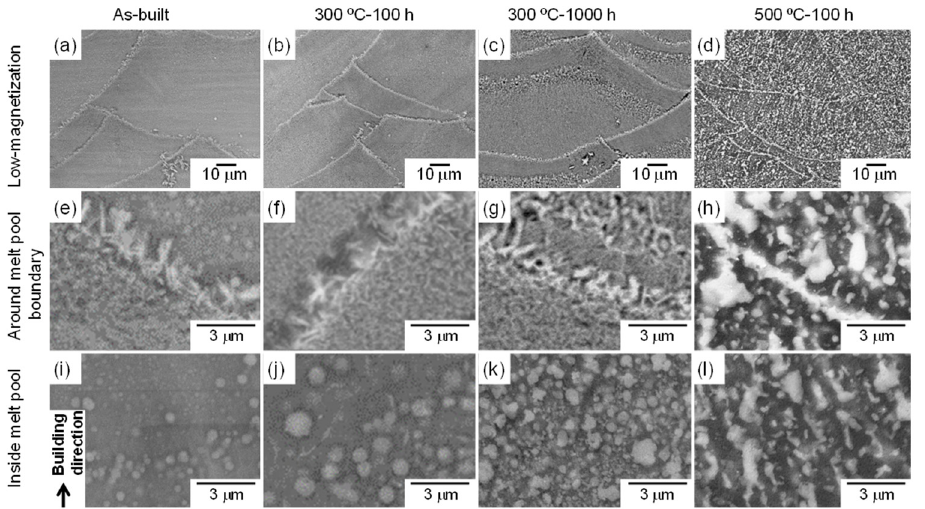
Figure 3. SEM images showing microstructures of ( a , e , i ) pristine and ( b – d , f – h , j – l ) thermally exposed L-PBF-built Al–15%Fe alloy samples: ( b , f , j ) 300 °C/100 h, ( c , g , k ) 300 °C/1000 h, and ( d , h , l ) 500 °C/100 h.